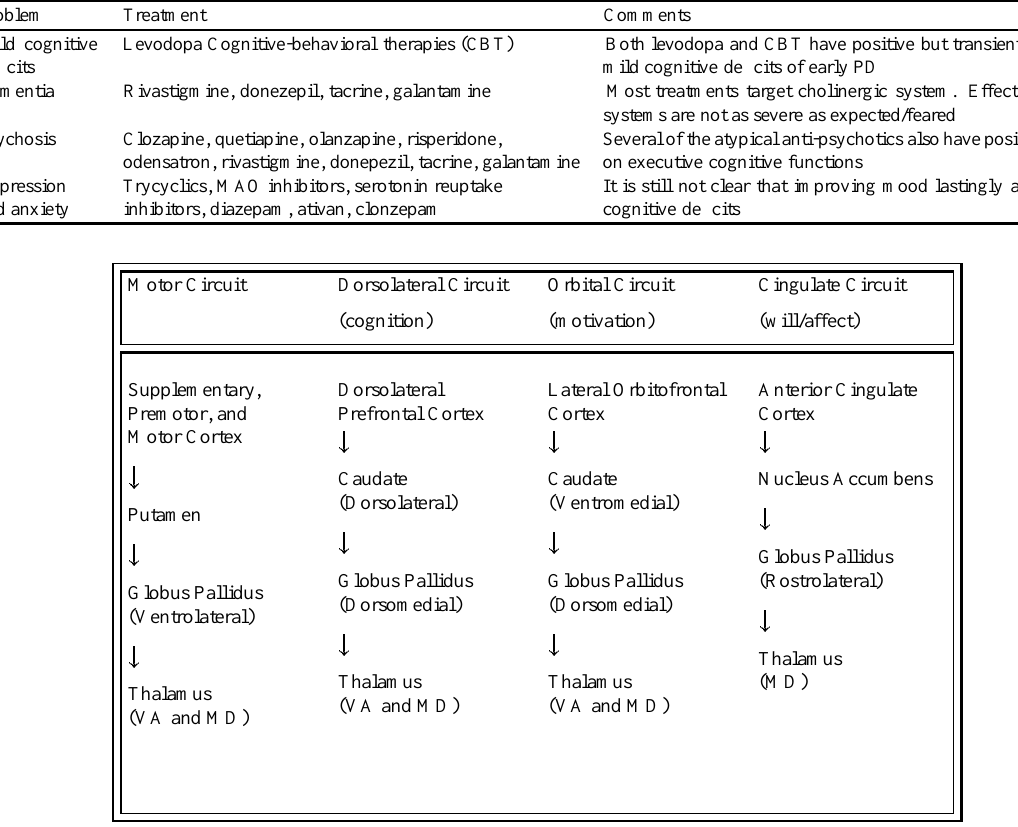
Fig. 1. Based ganglia- cortical loops affecting mental function in